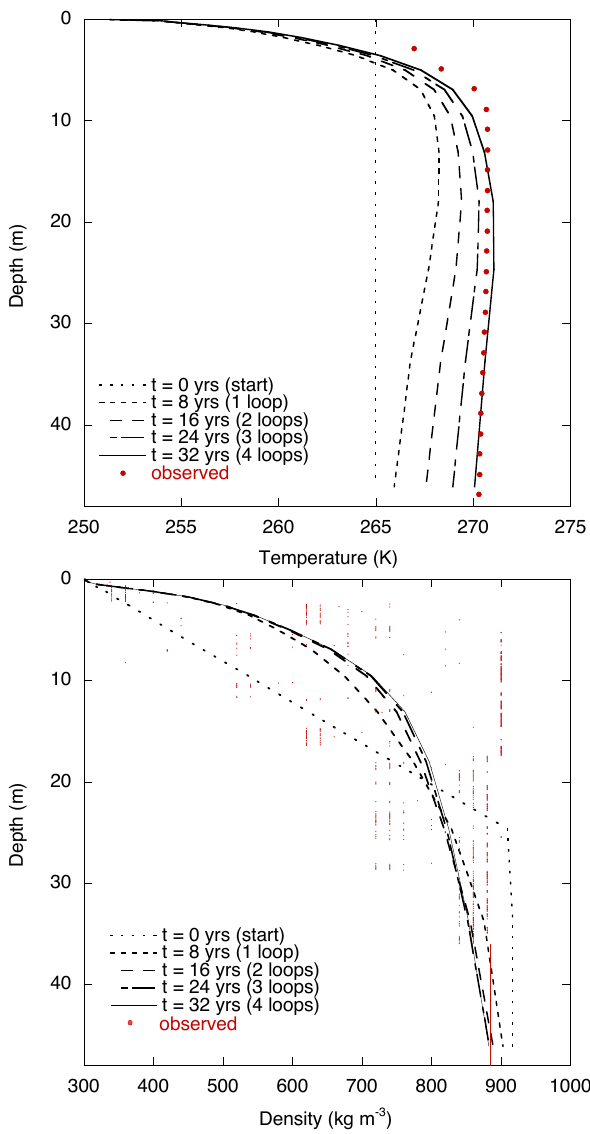
Fig. 3. Initialisation of the subsurface temperature (top panel) and density (bottom panel) at the ice core drill site. Observed vertical temperatures are taken from Van de Wal et al. (2002), whereas ob- served densities are adopted from Pohjola et al.